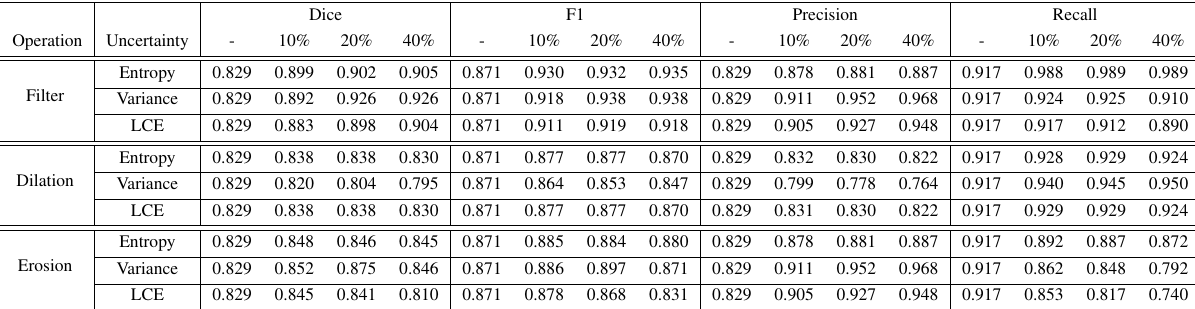
Table 1. Uncertainty indicators for erroneous predictions. We test the segmentation accuracy after filtering out the most 10%, 20% and 40% pixels and dilating/eroding these uncertain pixels.